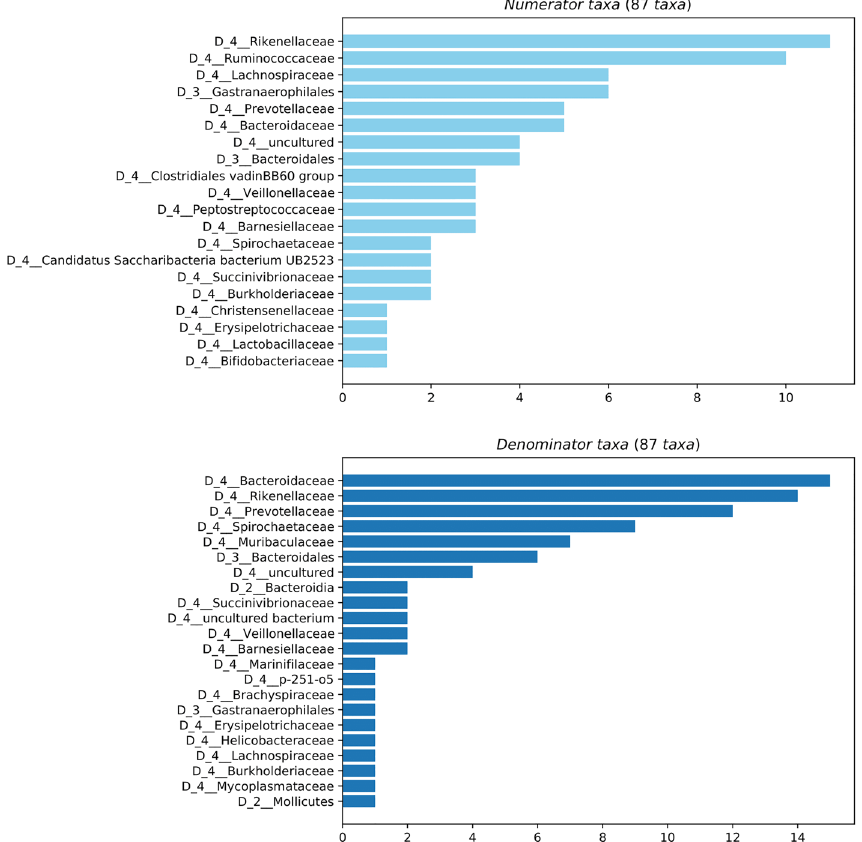
Figure 9. Taxonomy of the top and bottom 10% of discriminating features between housing systems. A log ratio of the relative abundance of these features was significantly higher in EC samples demonstrating an increased proportion of numerator features compared to denominator